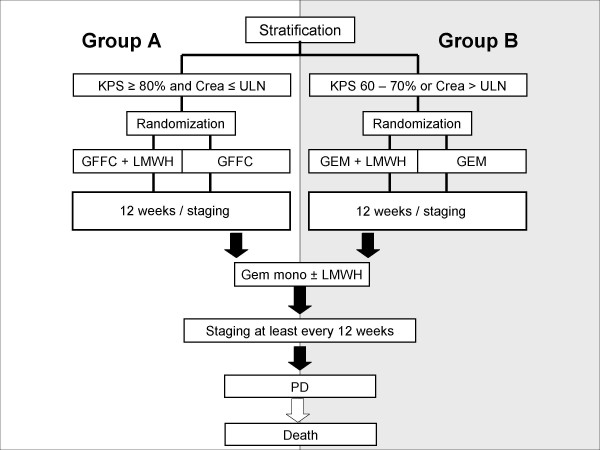
Study design. Figure legend text: KPS, Karnowsky Performance Status; Crea, Creatinine; ULN, upper limit of normal (> 1.1 mg/dl for men and > 0.9 mg/dl for women); GFFC, combination of gemcitabine, 5-fluorouracil, folinic acid and cisplatin; GEM, gemcitabine monotherapy; PD, partial remission; CR, complete remission.